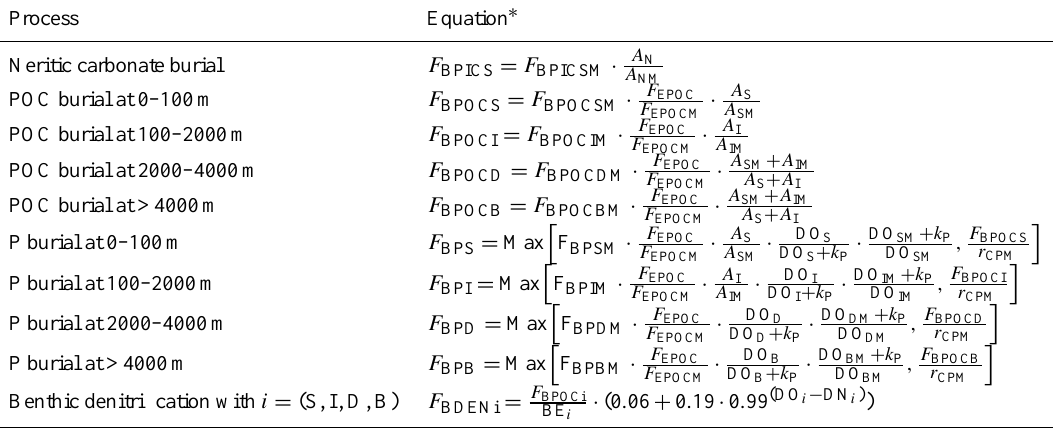
Table B2. Flux parametrizations applied in the simulation of margin processes.